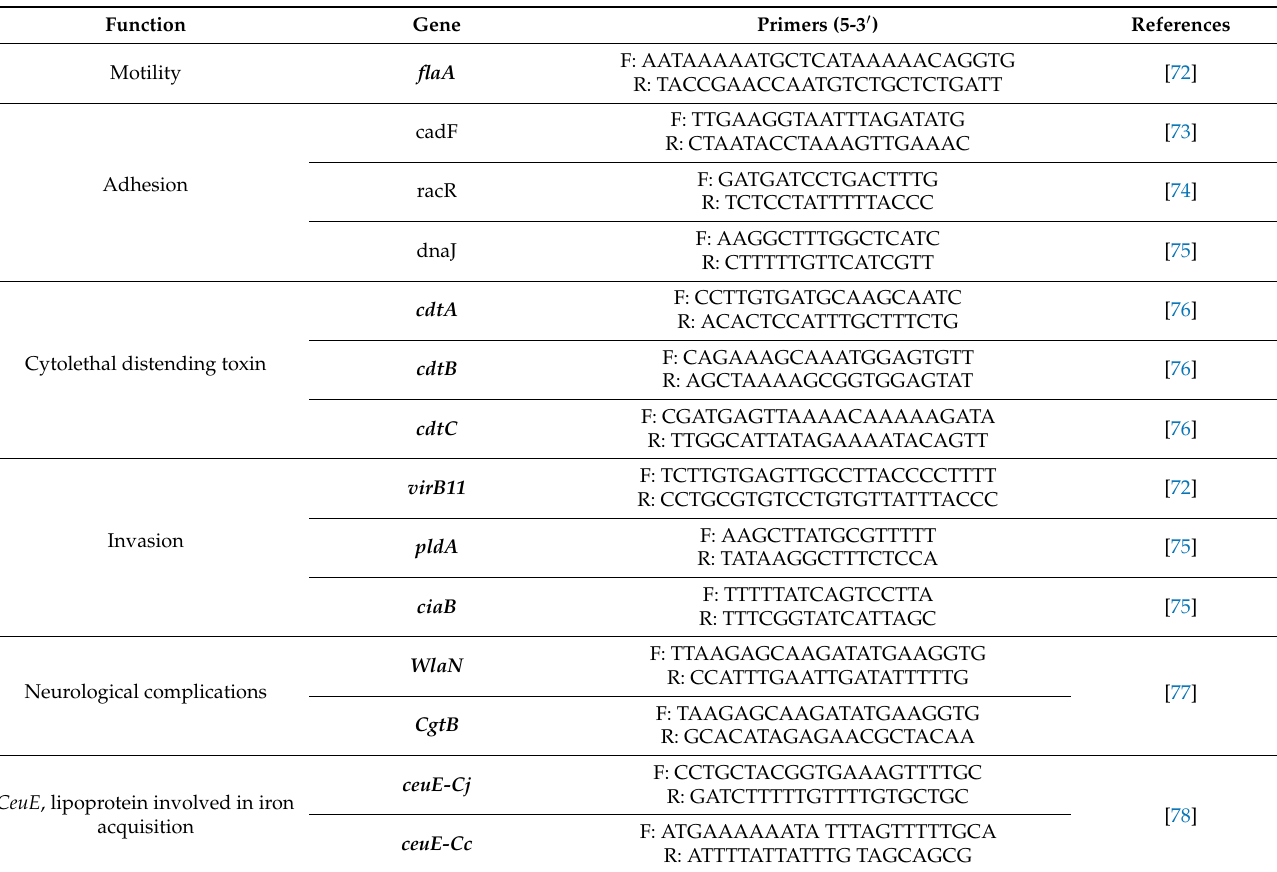
Table A1. Sequences of genes encoding virulence factors investigated in Campylobacter isolates.